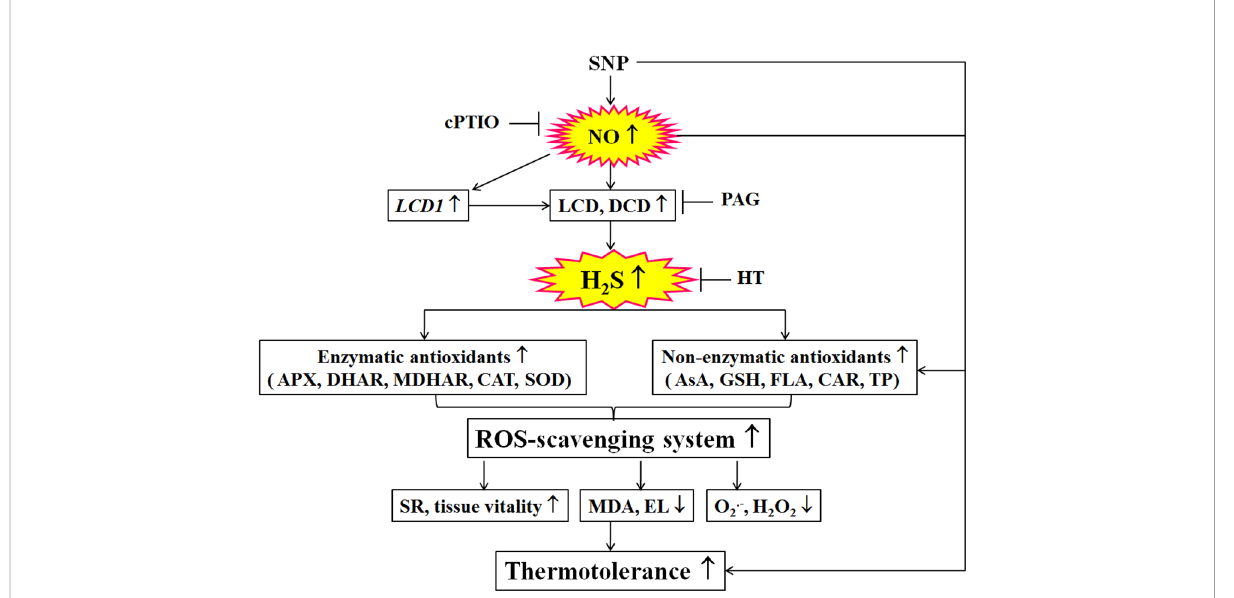
FIGURE 9 Mechanisms underlying nitric oxide (NO) and hydrogen sul fi de (H 2 S) crosstalk evoked thermotolerance in maize seedlings. Nitric oxide (NO) donor sodium nitroprusside (SNP) could trigger hydrogen sul fi de (H 2 S) signaling by up-regulated LCD1 expression and L-cysteine desulfhydrase (LCD) and D-cysteine desulfhydrase (DCD) activities. Then, the activity of the ROS-scavenging system, including enzymatic (ascorbate peroxidase, APX; dehydroascorbate reductase, DHAR; monodehydroascorbate reductase, MDHAR;glutathione reductase, GR; catalase, CAT; and superoxide dismutase, SOD) and non-enzymatic (ascorbic acid, AsA; glutathione, GSH; fl avonoids, FLA; carotenoids, CAR; and total phenols, TP) antioxidants, was enhance by SNP, which in turn increased survival rate (SR) and tissue viability, decreased electrolyte leakage (EL), malondialdehyde (MDA), superoxide radical (O 2.- ), and hydrogen peroxide (H 2 O 2 ) levels, thus evoking thermotolerance of maize seedlings. Also, the SNP-evoked thermotolerance could be weakened by 2-(4-carboxyphenyl)-4,4,5,5- tetrameth- ylimidazoline-1-oxyl-3-oxide (cPTIO), DL-propargylglycine (PGA), and hypotaurine (HT) alone, indicating that ROS-scavenging system plays a key role in the SNP-evoked thermotolerance in maize seedlings. The arrows ( ↑ ), ( ↓ ), and ( ⊥ ) denote increase, decrease, and inhibition,